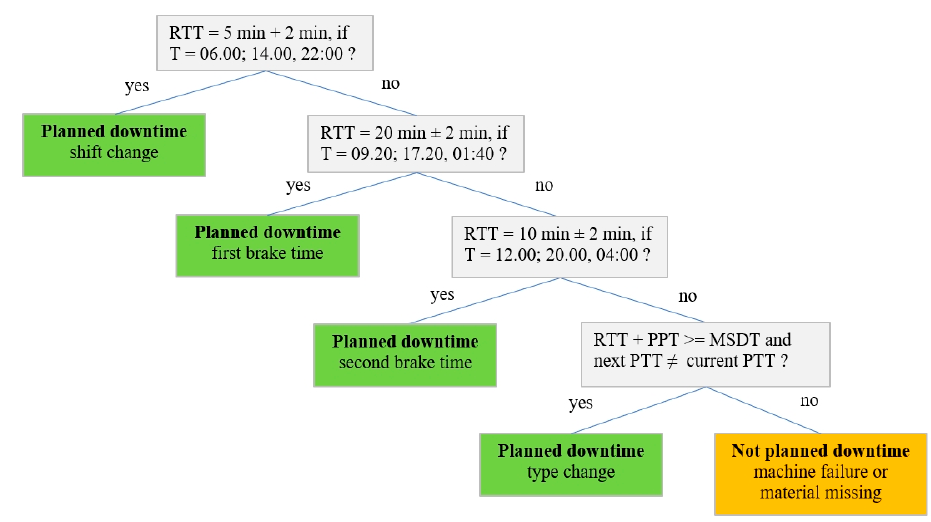
Figure 7. Decision tree for classification of different downtimes.